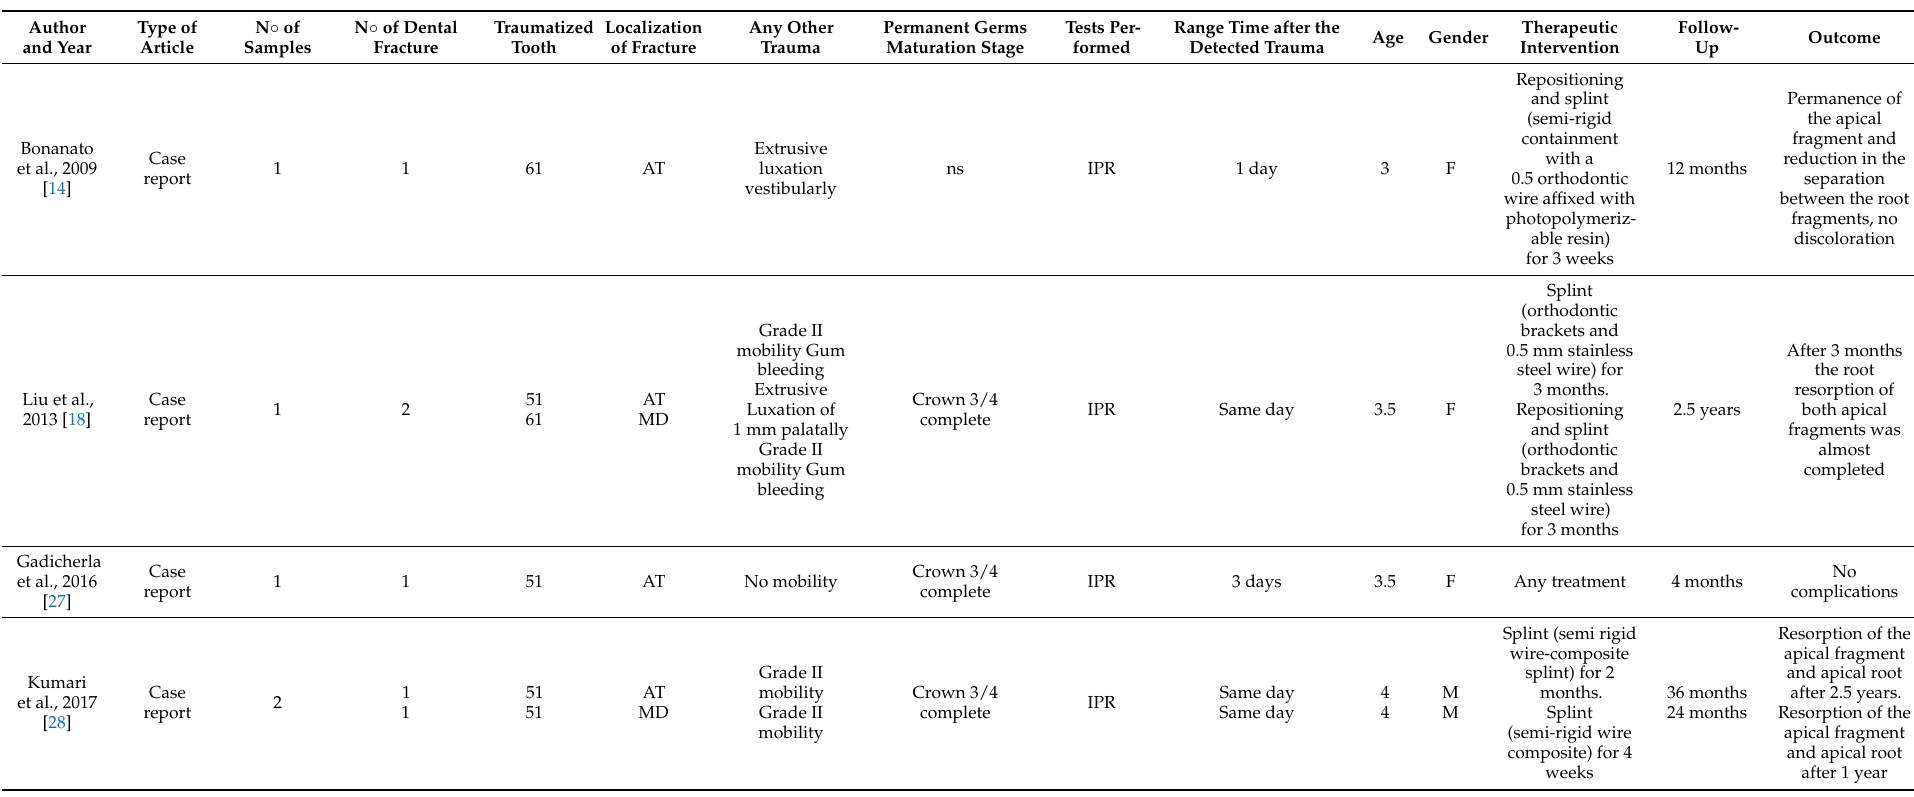
Table 1. Data from the eight articles included in the review. Legend: AT = apical third; MD = middle third; IPR = intraoral periapical radiograph; M = male; F =